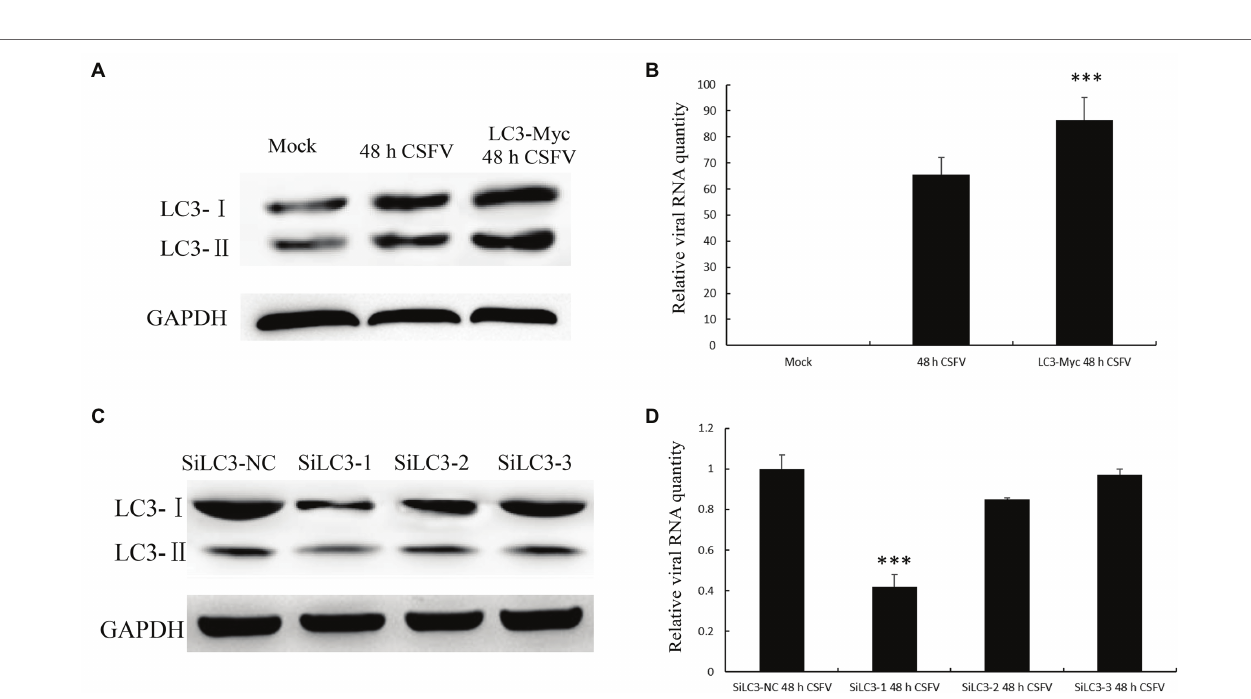
FIGURE 7 | The key amino acids of NS5A affect the expression of autophagy marker proteins. (A) PK-15 cells were transfected with constructs expressing NS5A with specific amino acid substitutions. The expression of LC3, ATG5, BECN1, and GAPDH (loading control) was analyzed by immunoblot with specific antibodies described in the Materials and Methods. The data represent the mean ± SD of three independent experiments. Statistical comparisons were evaluated using ANOVA followed by Tukey’s HSD post hoc analysis. *** p < 0.001, ** p < 0.01, compared with the mock group.